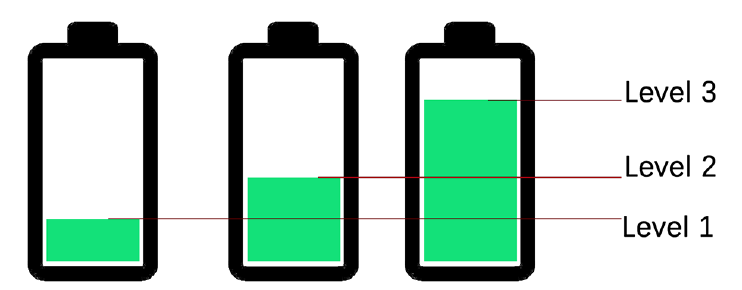
Figure 4. Energy level